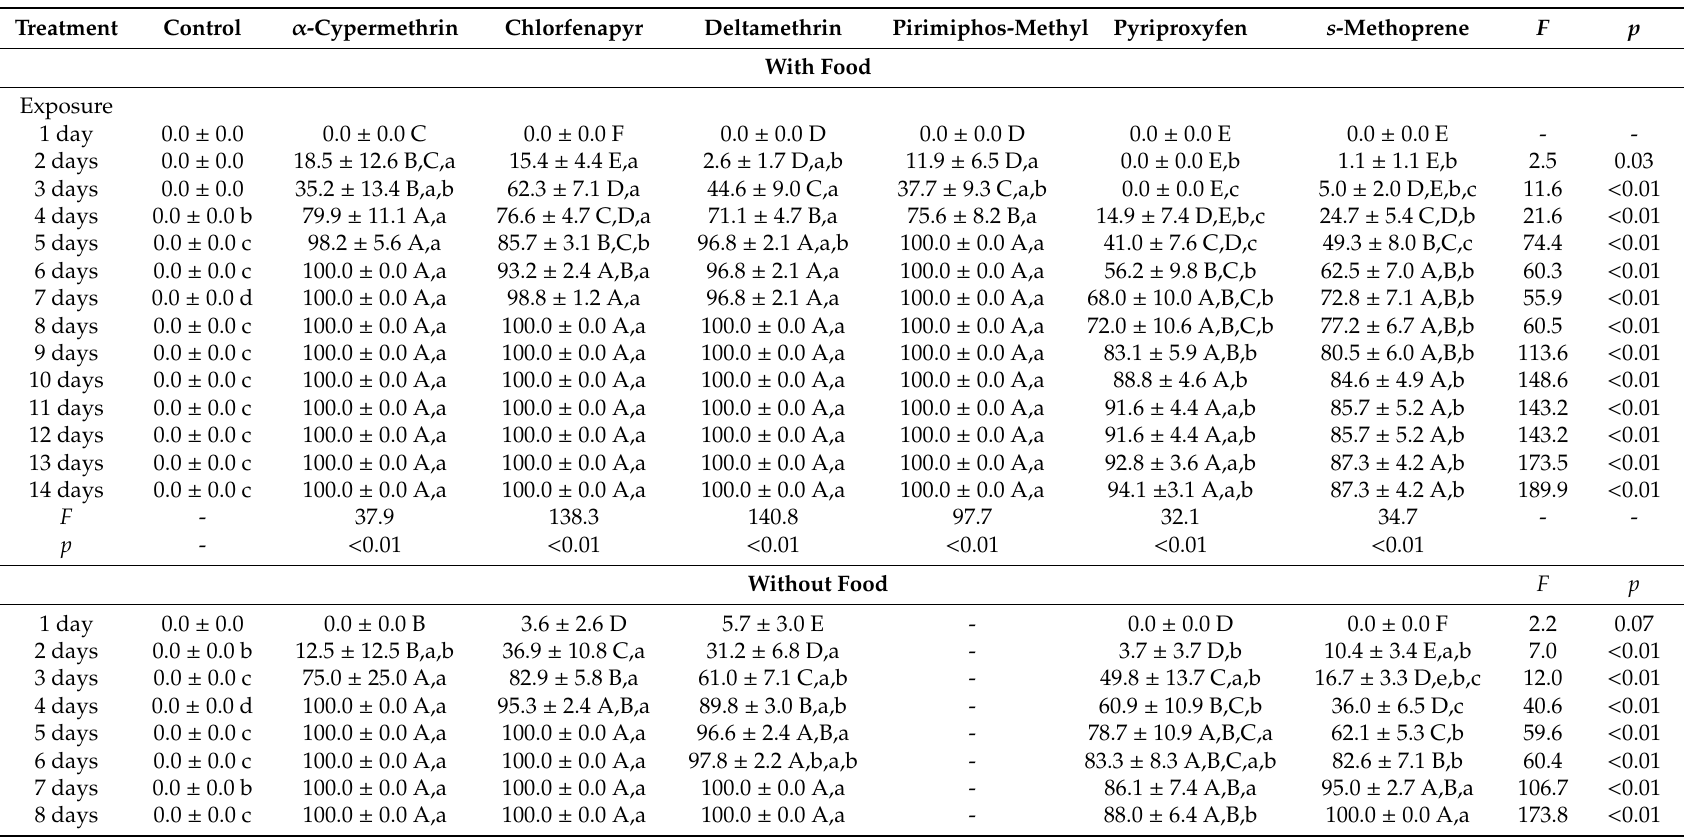
Table 3. Mean mortality (% ± SE) of Trogoderma granarium larvae on concrete treated with α -cypermethrin, chlorfenapyr, deltamethrin, pirimiphos-methyl, pyriproxyfen, and s -methoprene, and on untreated concrete (control) after 1, 2, 3, 4, 5, 6, 7, 8, 9, 10, 11, 12, 13, and 14 days with or without food. Within each column, means followed by the same uppercase letter are not significantly di ff erent (in all cases DF = 13, 125, except in the cases of pirimiphos-methyl with food DF = 13, 111 and α -cypermethrin without food DF = 13, 55, Tukey–Kramer HSD test at 0.05). Within each row, means followed by the same lowercase letter are not significantly di ff erent (in cases with food DF = 6, 61, in cases without food DF = 5, 48, Tukey–Kramer HSD test at 0.05). Where no letters exist, no significant di ff erences were recorded. Where dashes exist, no statistical analysis was